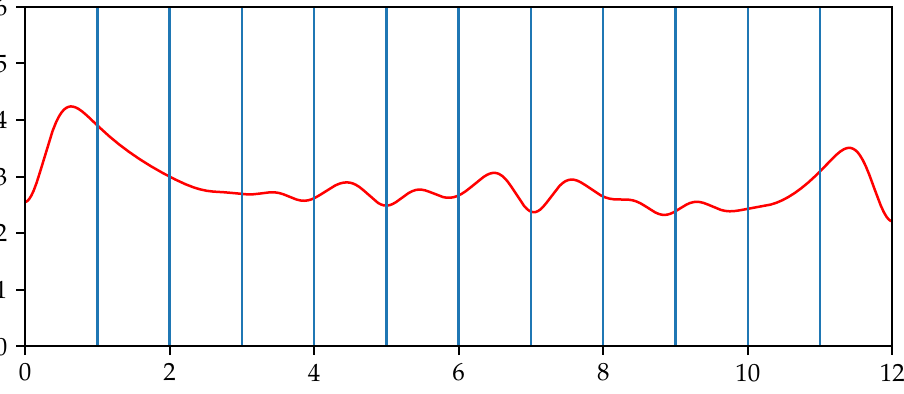
Figure 7. Logarithmic periodicities smoothed by a Gaussian with standard deviation of σ = JND/0.674490 ≈ 26.69